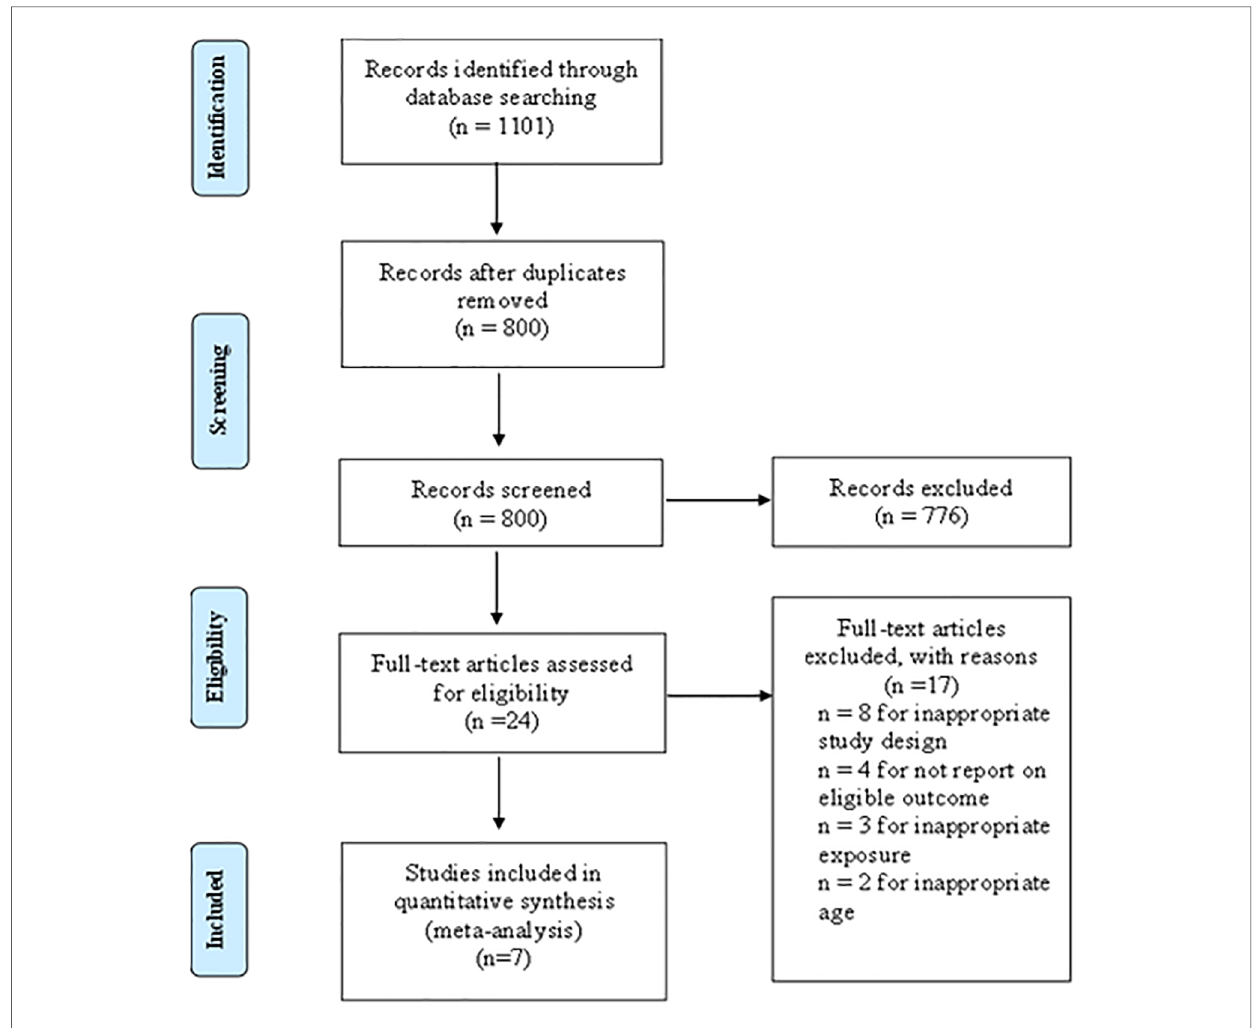
FIGURE 1 Study selection fl ow